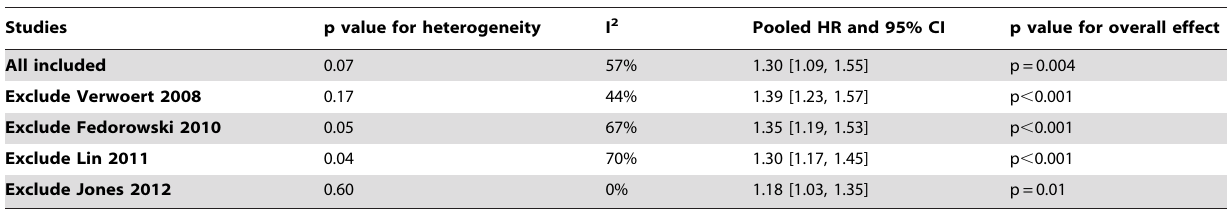
Table 3. Sensitivity